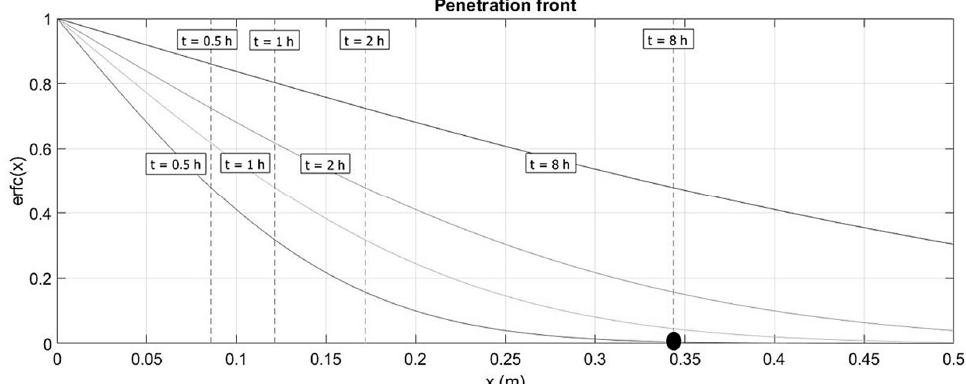
Figure 7. Progress of the heat front in a stainless-steel rod for times ranging from 0.5 to 8 h; dashed lines represent how deep into the material half of the possible temperature change has progressed.